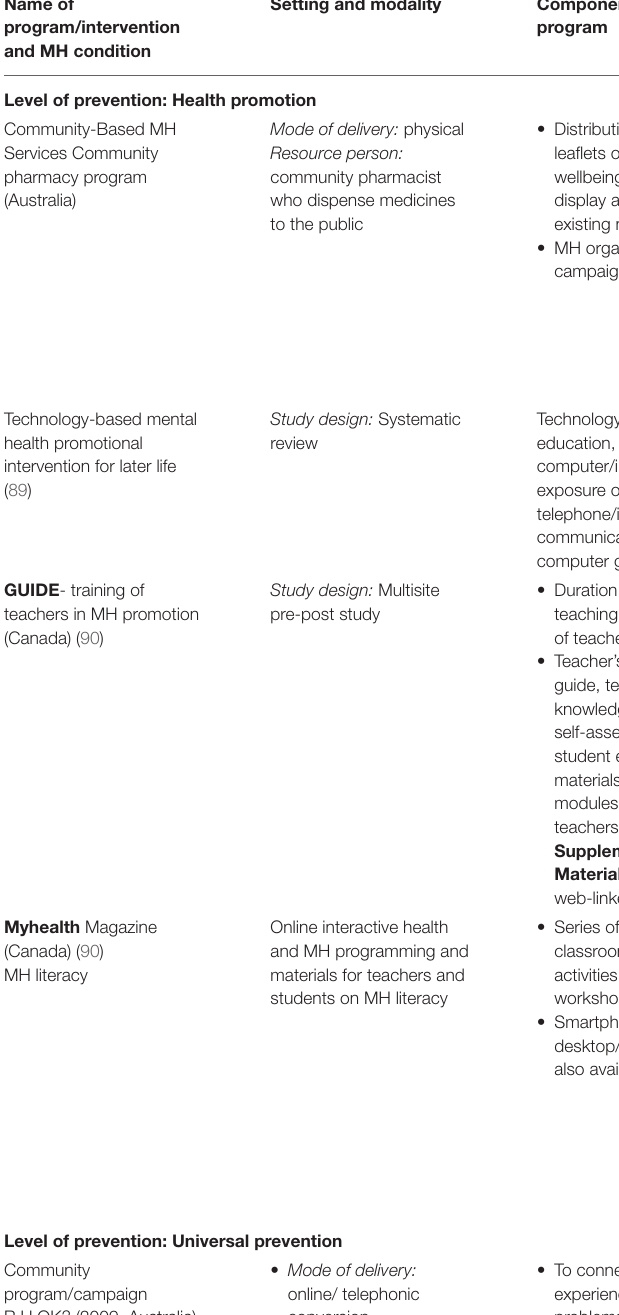
TABLE 2 | Depiction of various novel mental health promotion and prevention strategies. Name of